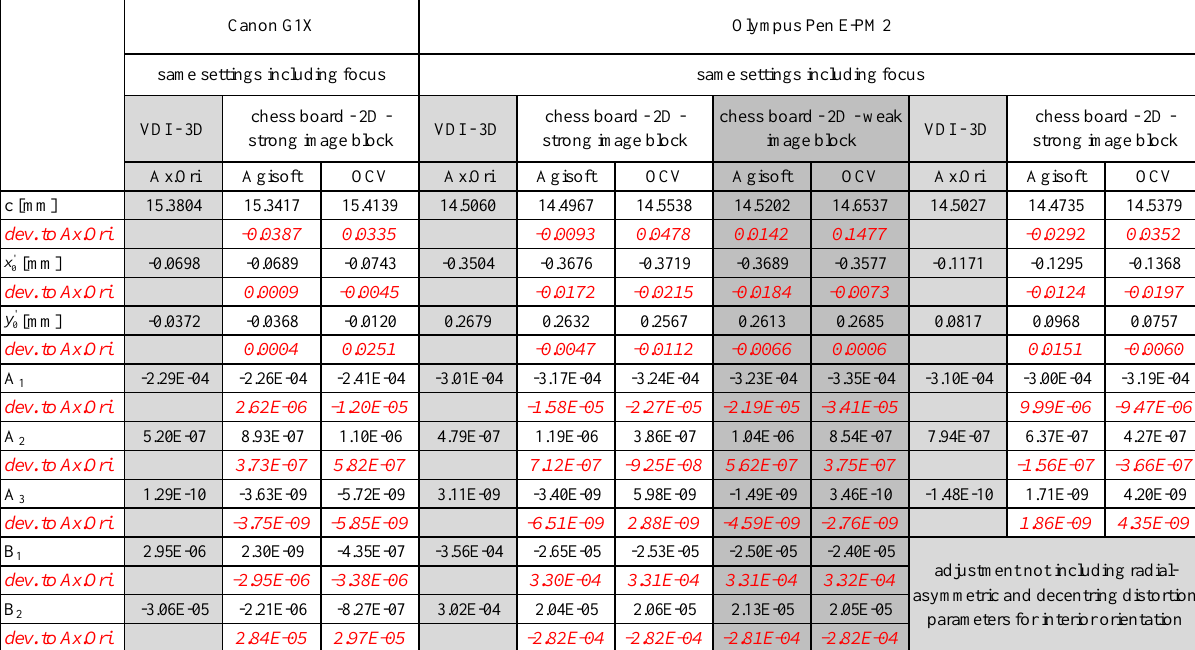
Table 3. Results of camera calibration on volumetric and planar patterns